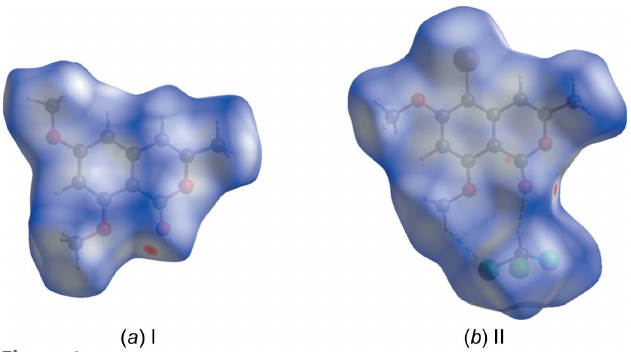
Figure 6 ( a ) The Hirshfeld surface of compound I , mapped over d norm , in the colour range (cid:5) 0.1596 to 1.1682 a.u., ( b ) the Hirshfeld surface of compound II (cid:2) CHCl 3 , mapped over d norm , in the colour range (cid:5) 0.0734 to 1.3731 a.u.. The dashed lines indicate the hydrogen bonds linking the two units (see Table